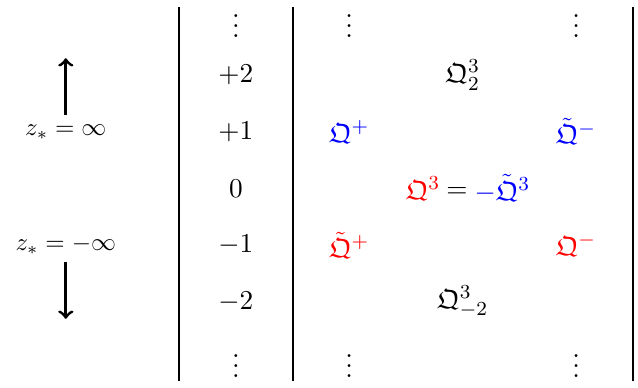
Figure 3 . The charges and their grades for the expansion of the monodromy matrix around the pair of special points z = (cid:6)1 (or 0 ; 1 with a multiplicative spectral parameter). The blue/red and positive/negative graded charges are associated to (cid:6)1 , respectively. The red and blue charges generate the a(cid:14)ne quantum group in principal gradation and all the other charges are obtained by repeated Poisson brackets of these